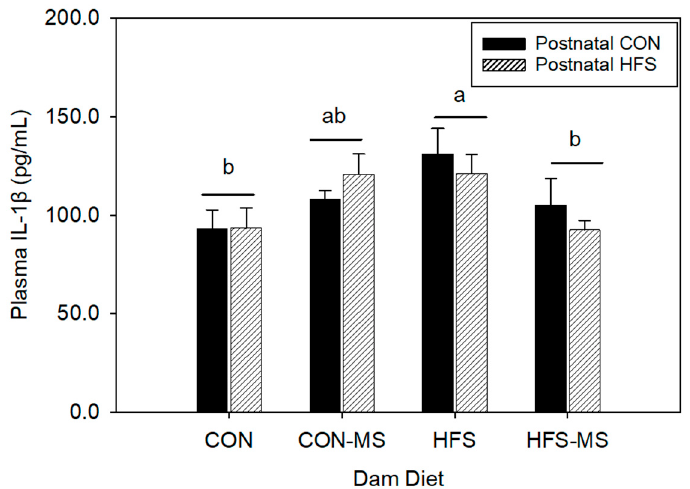
Figure 2. Plasma levels of IL-1 β in adult offspring born to dams fed a control (CON) or high-fat, high sucrose (HFS) diet with or without methyl-donor nutrient supplementation (MS). All data are pooled from both sexes. Different letters indicate significant differences between maternal diets at p < 0.05. Data are expressed as mean ± SEM ( n = 10/group). Postnatal CON, control postnatal diet; postnatal HFS, high-fat, high-sucrose postnatal diet.